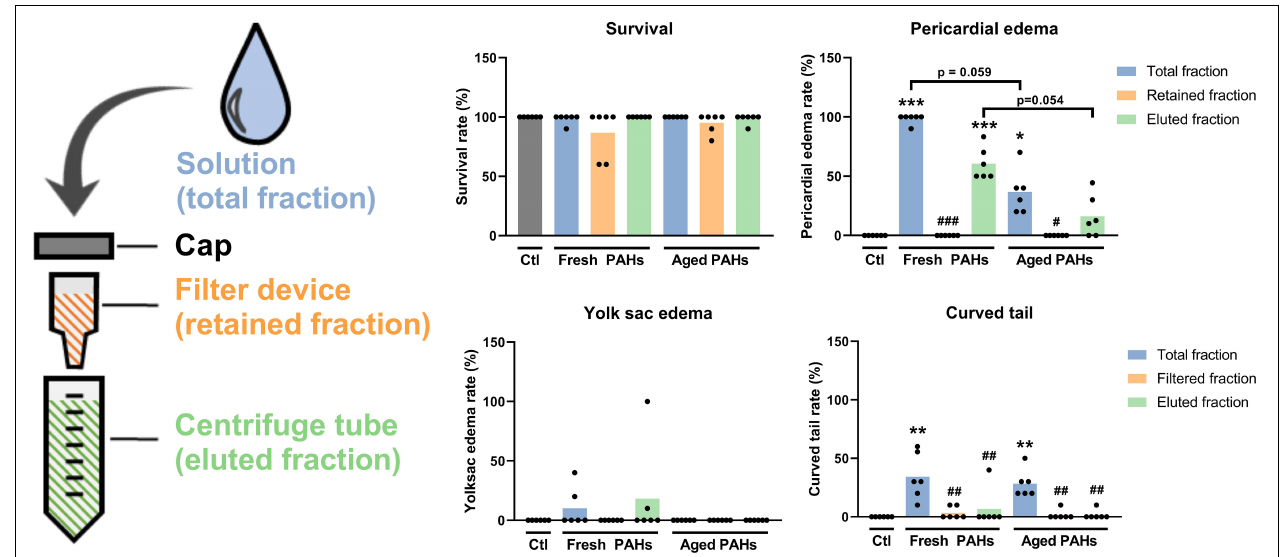
FIGURE 2 | Analysis of the incubation and ultrafiltration on the acute toxicity of the PAH solution to embryonic and larval zebrafish. Animals at 6 h post-fertilization (hpf) were exposed to different ultrafiltration fractions of freshly prepared (fresh) 7 days old (aged) 5% Elizabeth River Sediment Extract as a model environmental PAH solution. The total fraction represents an unfiltered solution, while the retained and eluted fractions are collected by ultrafiltration. Animals were analyzed at the end of the exposure (96 hpf). Data were analyzed by Kruskal-Wallis followed by the two-stage set-up method of Benjamin, Krieger, and Yekutieli for controlling the false discovery rate. Differences relative to the Ctl are shown as *, **, or *** ( p < 0.05, 0.01, or 0.001) on top of the bars, while differences relative to the respective “total fraction” are shown as # , ## , or ### ( p < 0.05, 0.01, or 0.001) (all p -values were adjusted to the false discovery rate of